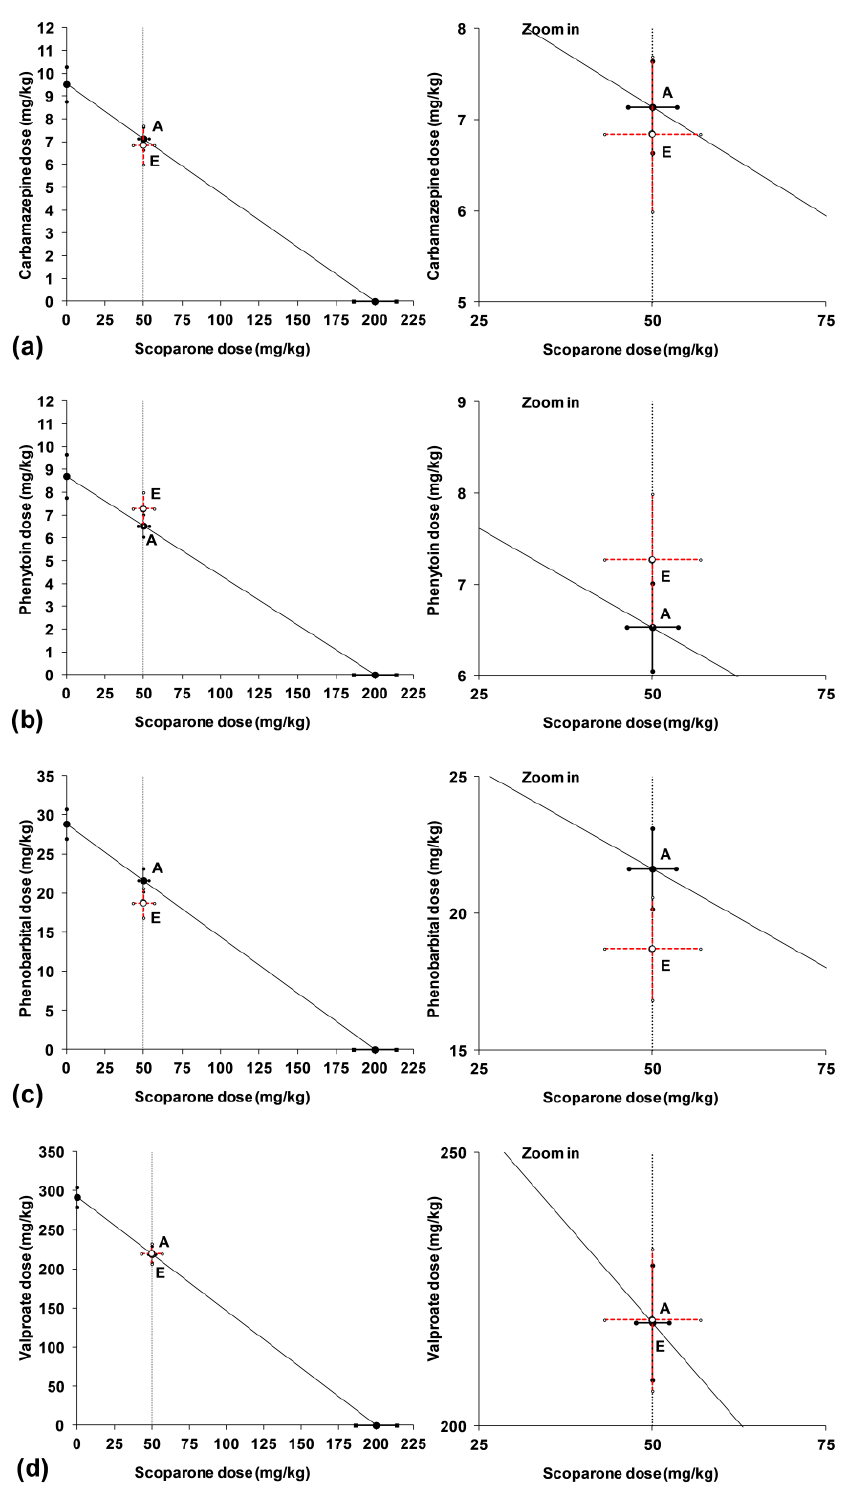
Figure 3. Isobolographic transformation of data for interactions between classic antiseizure medications and scoparone in the mouse MES model. Interactions between scoparone and carbamazepine ( a ), phenytoin ( b ), phenobarbital ( c ) and valproate ( d ) are plotted on isobolograms. The constant dose of scoparone in mixture is parallel to the Y-axis. The oblique line connecting the ED 50 values of X- and Y-axes (as the line of additivity) reflects the theoretically calculated ED 50add values. Point A reflects the theoretically calculated ED 50add value for the two-drug mixture (scoparone + ASM), whereas the experimentally derived ED 50exp is illustrated graphically as point E.